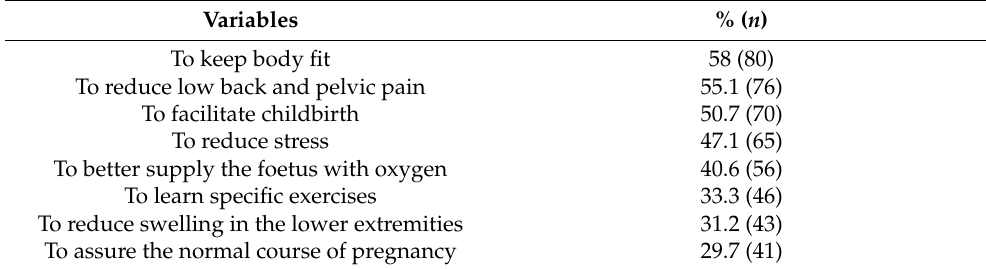
Table 3. Distribution of all answers to the question “Why should women attend exercise classes during